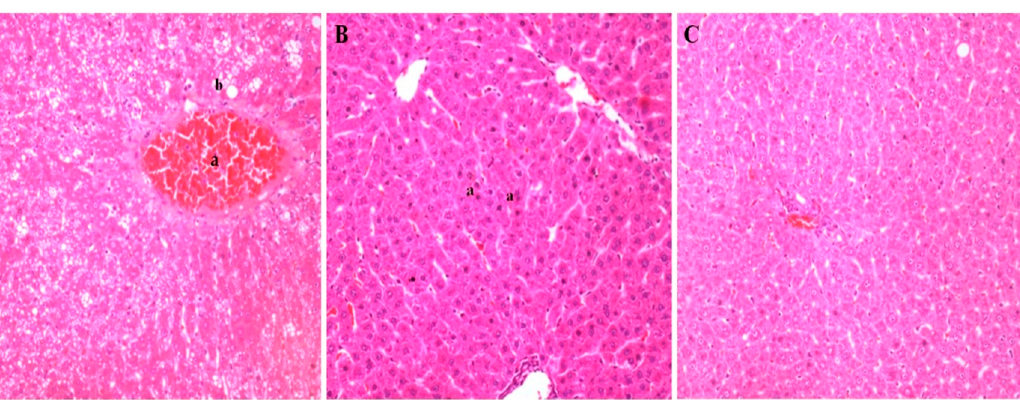
Figure 3. Histopathological liver alterations of rats fed the high-fat feed during phase 1 ( A – C ). Panel A shows the thickening of connective tissue capsule in the portal triad (a), proliferation of bile ducts (b), anddilation of the portal vein branch (c). Panel B indicates the presence of mononuclear cell inflammatory infiltrates (a); hematoxylin and eosin(H&E), 40×. Panel C indicates the presence of hepatocyte necrosis areas (a) and micro and macro vesicular steatosis (b). Panel D represents the liver of animals fed the standard feed AIN-93G. Photographs were recorded at 20× magnification (H&E staining).